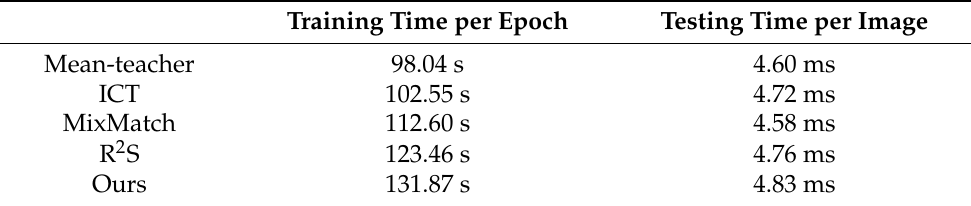
Table 7. Time analysis of the proposed method, Mean-teacher, ICT, MixMatch, and R 2